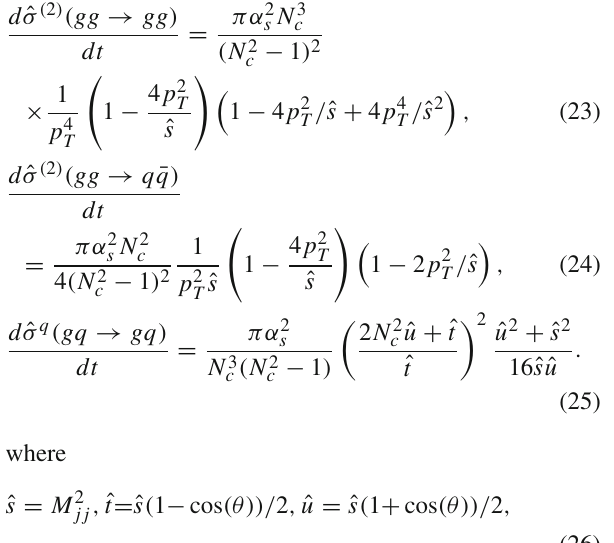
Fig. 4 The cross section of three jet semi-exclusive central production integrated over the third jet transverse momentum k 3 up to 3, 6 and 10 GeV (respectively shown by blue, black and red continuous curves) at √ s = 13 TeV as the function of the ratio R jj = M jj / M X . The two high E T jets have p T = 30 GeV and pseudorapidities η j = ± 1 . 75, Y jj = 0. An infrared cutoff m g = q IP = 0 . 2 GeV was used for the main calculation shown by continuous curves. Two alternative choices of cutoff are also shown: m g = 0 . 7 GeV corresponding to the long dashed curve with k 3 < 6 GeV, while q IP = 1 GeV and m g = 0 . 2 GeV corresponds to the lower dashed curve ( k 3 < 6 GeV). The pure exclusive dijet cross section reduced by factor of 1000 is shown by the horizontal short dashed line. We used the integrated MMHT2014 parton distributions [32] (for the ’hard’ Pomeron) and the H1 fit B for the diffractive parton distributions [11] for the soft